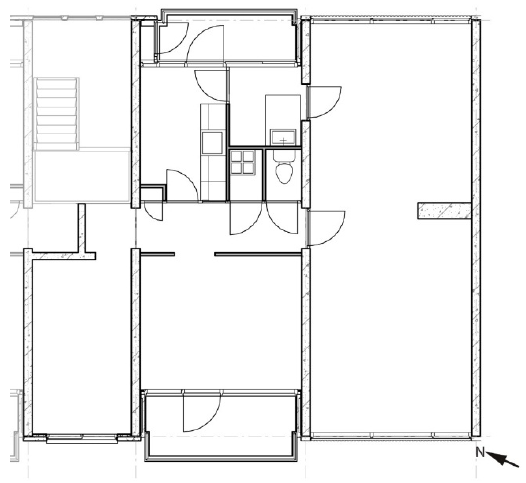
Figure 4. Floor plan of the right top corner apartment of the case study building [39].